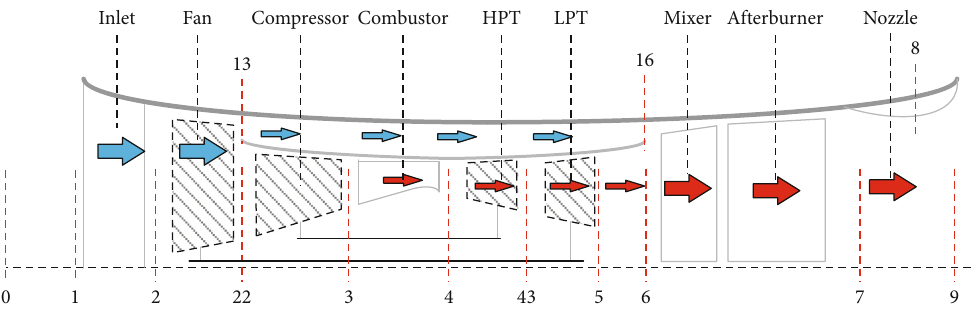
Figure 6: Diagram of a two-spool turbofan